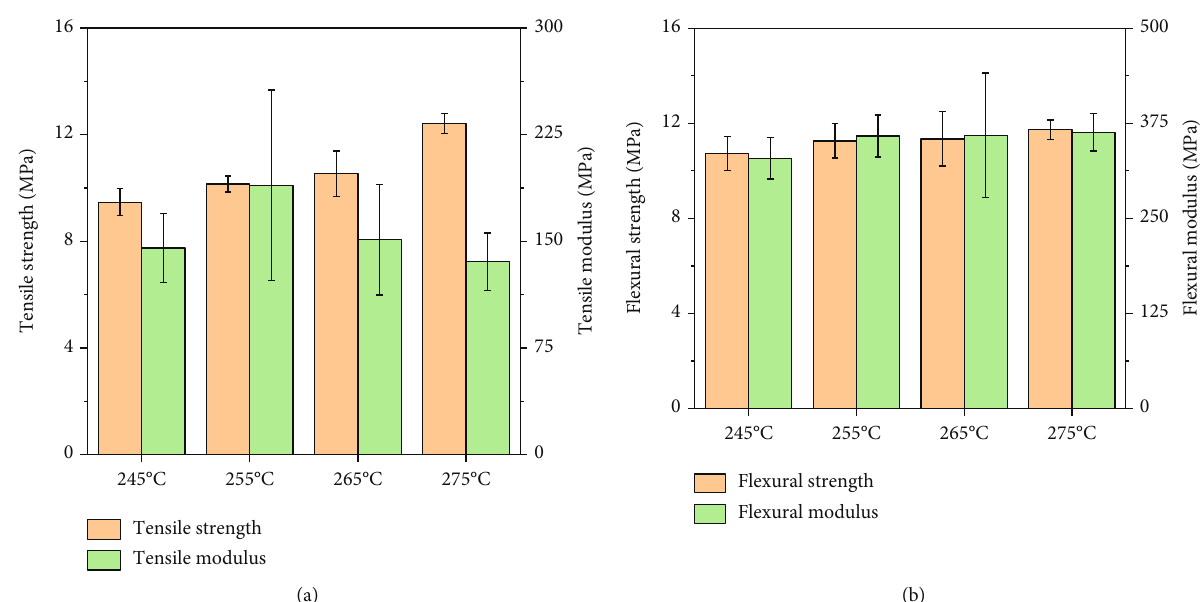
PE PET (with 2 wt% PP-g-MAH) specimens and (b) its fl exural 34 51 13